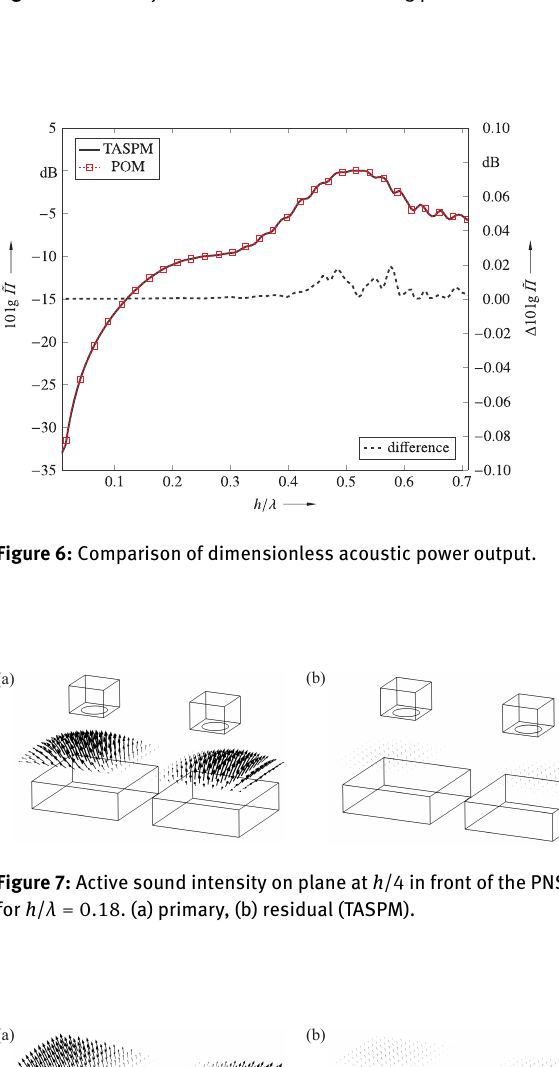
Figure 5: Geometry of numerical model including piston sources.